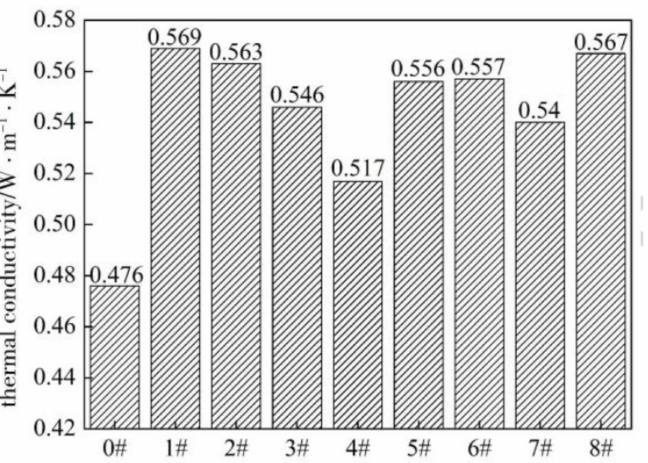
Figure 6. Trend of the thermal conductivity for neat (0#) and differently surface-modified (1#-8#) graphite/NR composites [148]. Copyright © 2021 Elsevier B.V. All rights